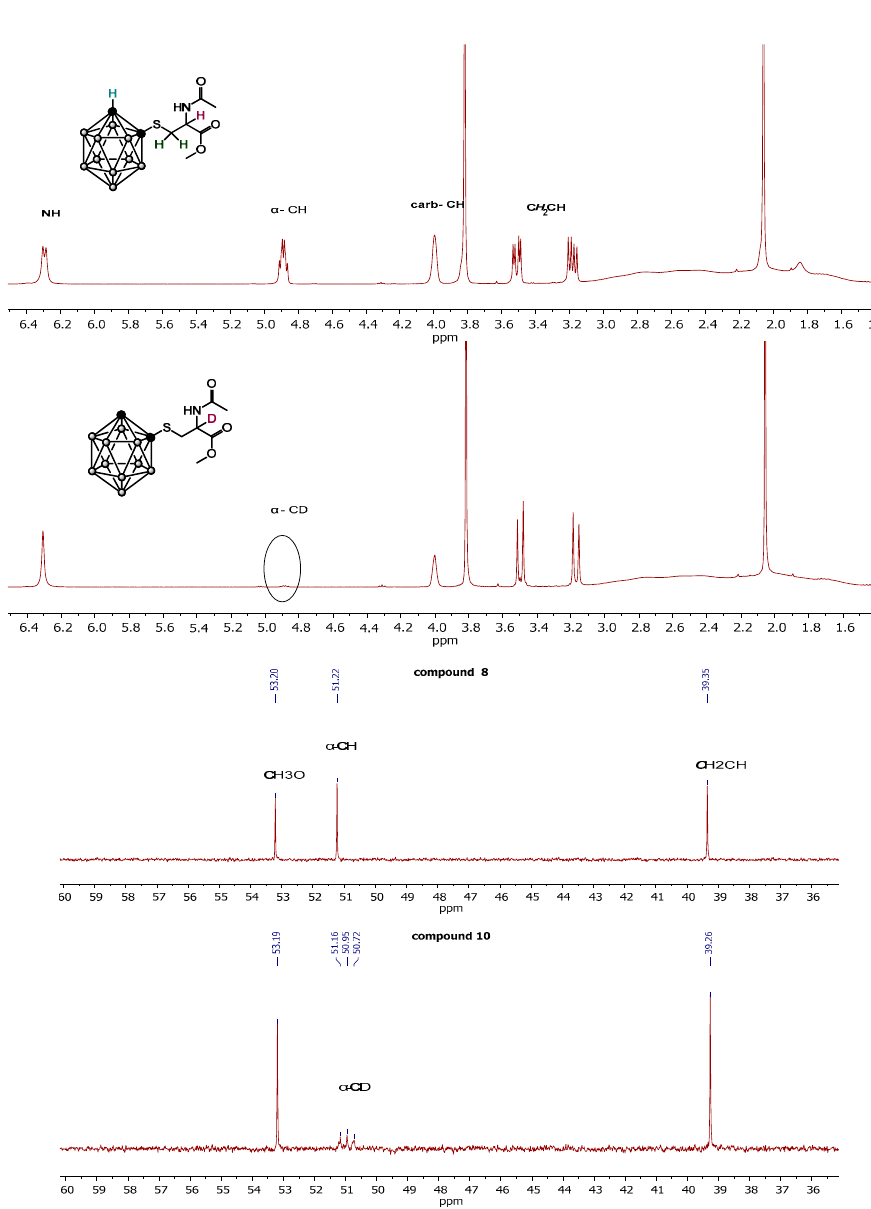
Figure 6. Comparison of 1 H NMR and fragments of the 13 C NMR spectra of 8 and 10 in CDCl 3 . The subsequent acid hydrolysis of 10 resulted in the o-carboranyl-cysteine 11, labeled at the α -position of the amino acid (Scheme 3). The 1 H NMR spectrum of 10 in CDCl 3 does not contain the multiplet at 4.90 ppm, which indicates the absence of a proton at the α - position of the amino acid, whereas in the 13 C-NMR spectrum the triplet due to the C 2 H group appears at 51.0 ppm, indicating the substitution of H for 2 H. In addition, the doublet of the NH group (6.17 ppm) and two doublets of doublets from the methylene CH 2 protons, which were detected in the 1 H NMR spectrum of 8 , collapsed to a singlet and two doublets in the spectrum of [ α - 2 H]carboranyl-cysteine 10, respectively, due to the absence of an adjacent proton.